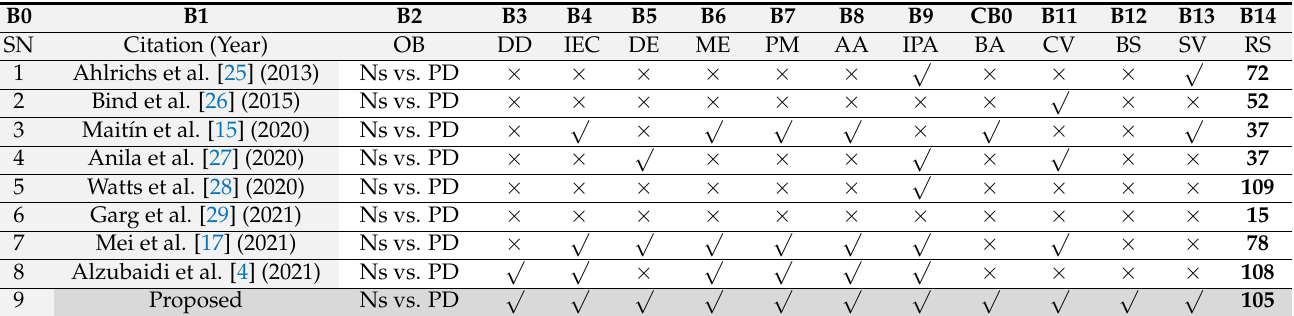
Table 3. Benchmarking scheme for selected and proposed